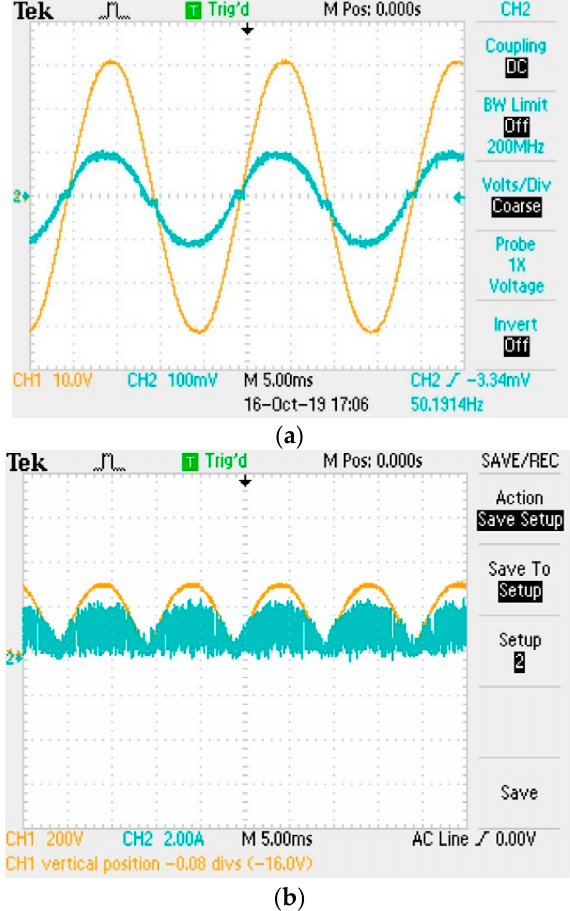
Figure 18. ( a ) Experimental results of input voltage/current, and ( b ) experimental results of full ‐ bridge rectifier voltage and inductor current of boost PFC.